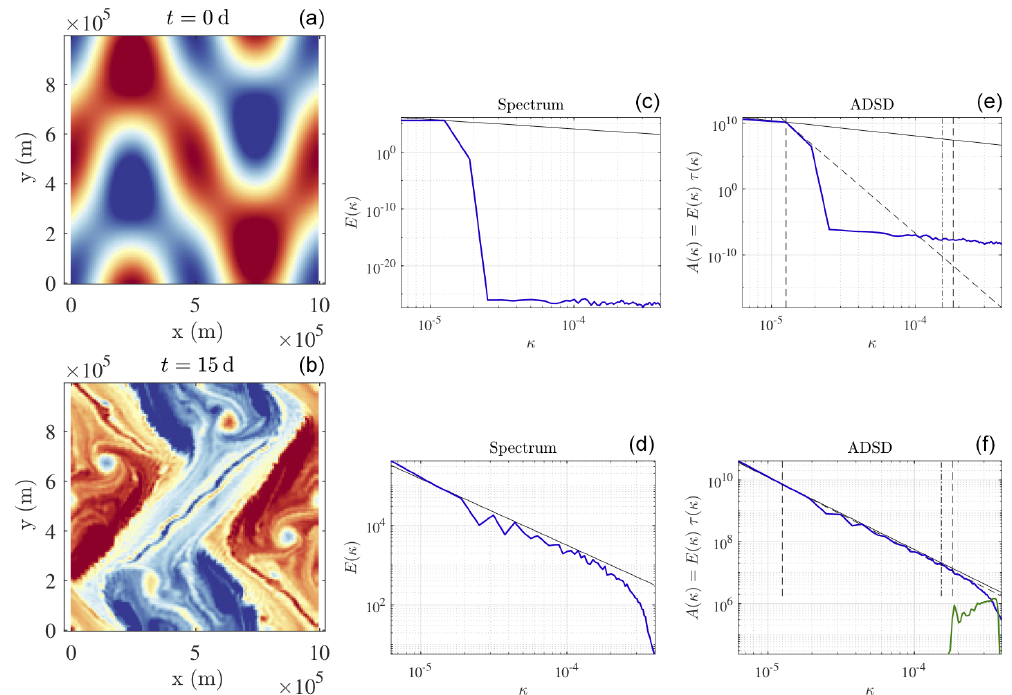
Figure 1. Buoyancy field (ms − 2 ) (a, b) , KE spectrum (m 2 s − 2 / (radm − 1 )) (c, d) , and ADSD (m 2 s − 1 / (radm − 1 )) (e, f) of the resolved velocity, at t = 0d (a, ce) and t = 15d (b, d, f) , in blue; ADSD of the unresolved velocity (without a multiplicative constant), in green; and (c, d) and corresponding ADSD (e, f) in a black solid line. The two dashed vertical lines define the interval where coefficients slope − 5 3 C w and r w are fitted. The right-hand-side dashed vertical line is fixed (see Appendix B for its specification). The left-hand-side dashed line corresponds to the energy-injecting scale. This scale is estimated – at each time step – as corresponding to the maximum of the compensated KE spectrum (i.e. KE spectrum divided by a theoretical spectrum). The dashed oblique line is the resulting fit (it is set to meet A w in the left bound of the fitting interval). The unresolved velocity is still restricted to a narrow spectral band, specifically between the dotted dashed line and the right end of the plot. Nevertheless, the form of its spectrum varies in time and is determined by the spectrum of the large-scale velocity. This particular initial condition corresponds to case 2 studied by Constantin et al. (1994, 1999, 2012) at a resolution of 128 2